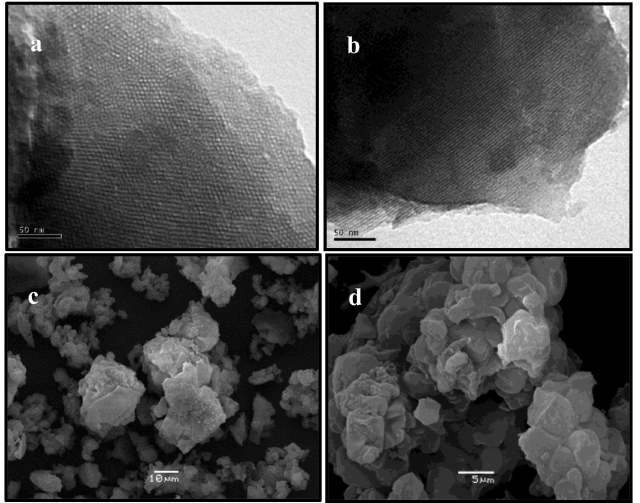
Figure 2. Transmission Electron Microscopy (TEM) and Scanning Electron Microscopy (SEM) images of ( a – c ) MCM-41, and ( b – d ) Zn/MCM-41(2.5) (taken as